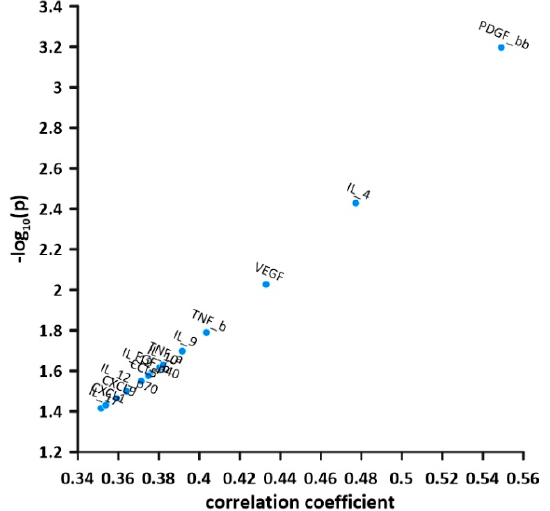
Figure 2. Volcano plot of the correlation of soluble cytokine levels with the degree of acute cellular rejection (correlation coefficient on the x-axis). The y-axis represents the − 1× the logarithmised level of significance for each cytokine correlation. − log ( p = 0.05) = 1.3.